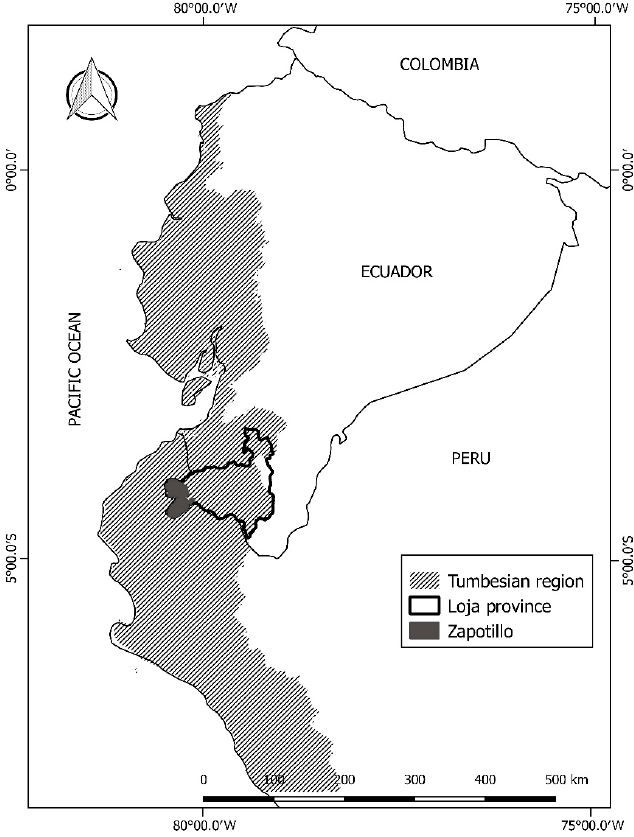
Figure 1. Map of the Tumbesian region and the canton Zapotillo in the province of Loja, Ecuador.